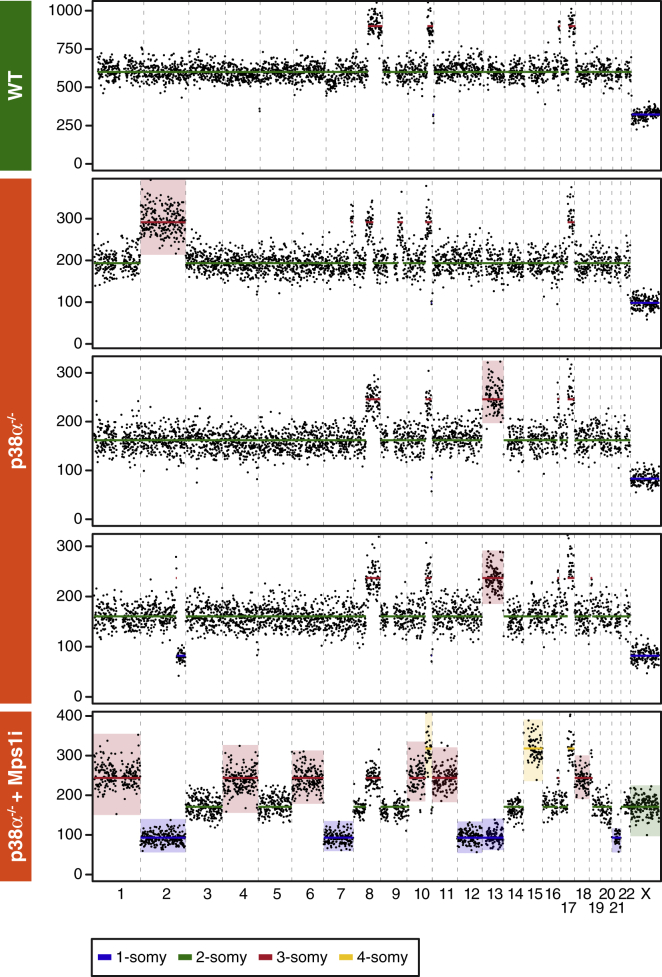
p38α-Deficient Cells Accumulate Whole-Chromosome ΑneuploidiesGenome-wide chromosome copy-number profile of parental and p38α null cells as determined by single-cell sequencing, with colored boxes highlighting whole-chromosome aneuploidies not observed in parental cells. See also Figure S6.